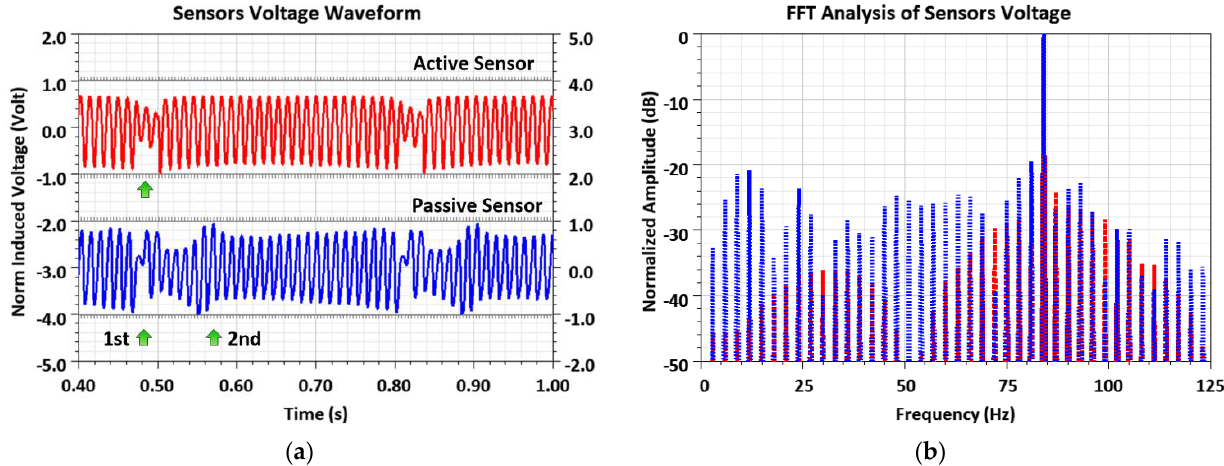
Figure 9. FEM model of a rotor with a broken end-ring segment: ( a ) normalized waveforms of the induced voltages in the sensors; ( b ) FFT analysis of induced voltage waveforms.